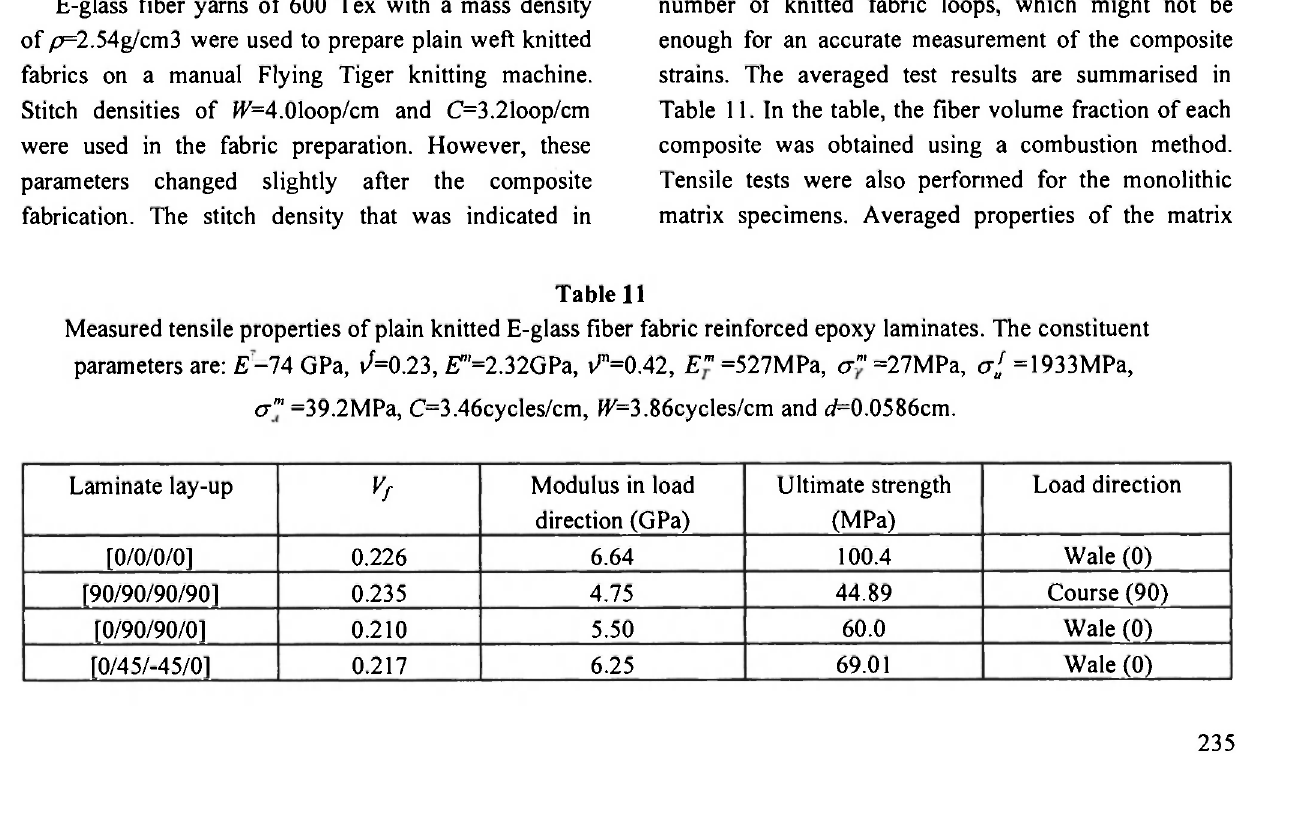
Measured tensile properties of plain knitted Ε-glass fiber fabric reinforced epoxy laminates. The constituent parameters are: £ - 74 GPa, v/=0.23, £"'=2.32GPa, 1^=0.42, E* =527MPa, σ" =27MPa, σ'„